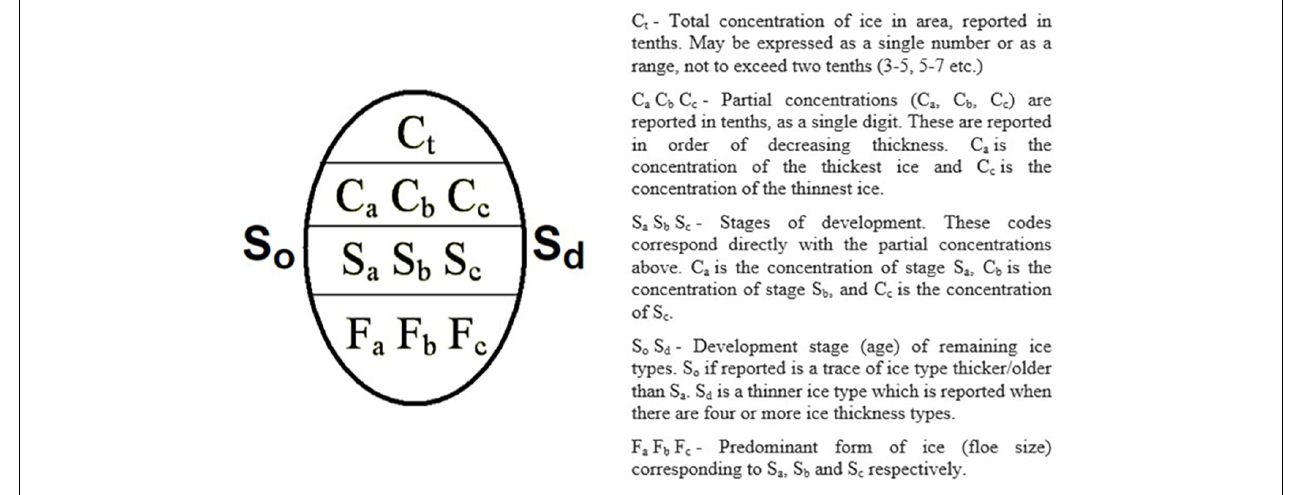
FIGURE 1 | WMO egg code (JCOMM Expert Team on Sea Ice, 2014). Contained in the simple oval are data regarding concentrations, stages of development, and form of ice. Code conforms to an international